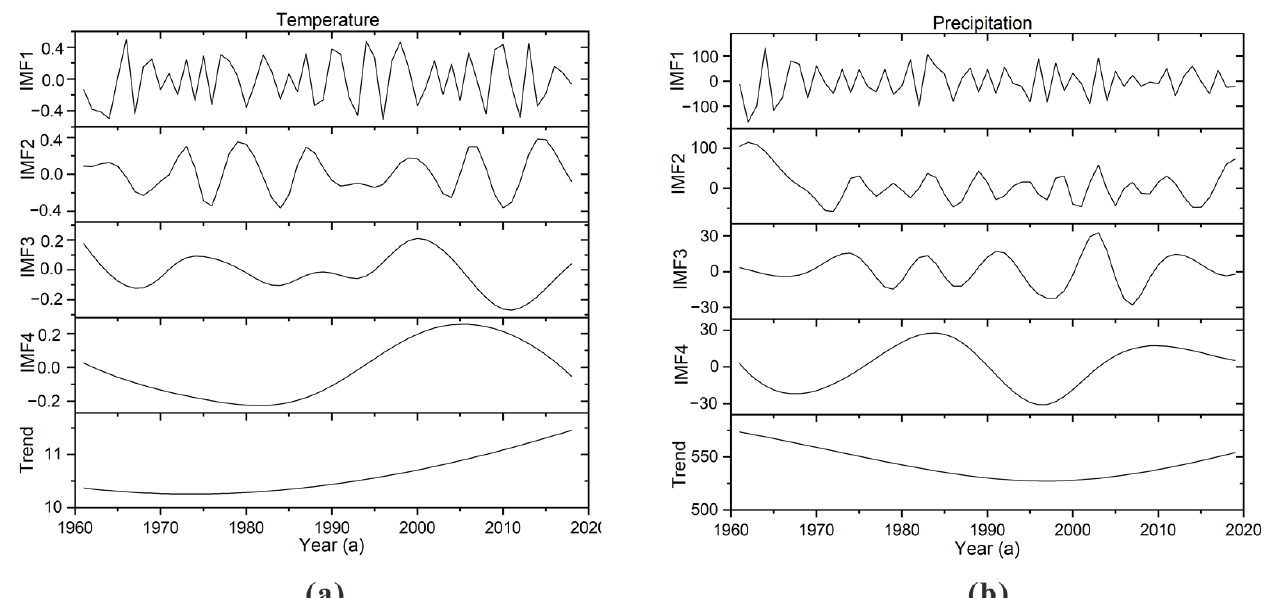
Figure 4. Decomposition of ( a ) temperature and ( b ) precipitation variation derived from EEMD.